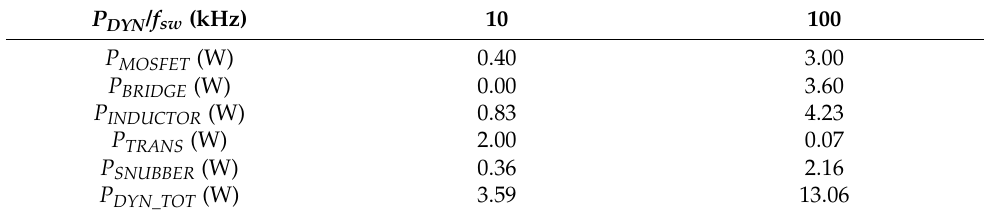
Table 4. Distribution of dynamic power losses P IN = 300